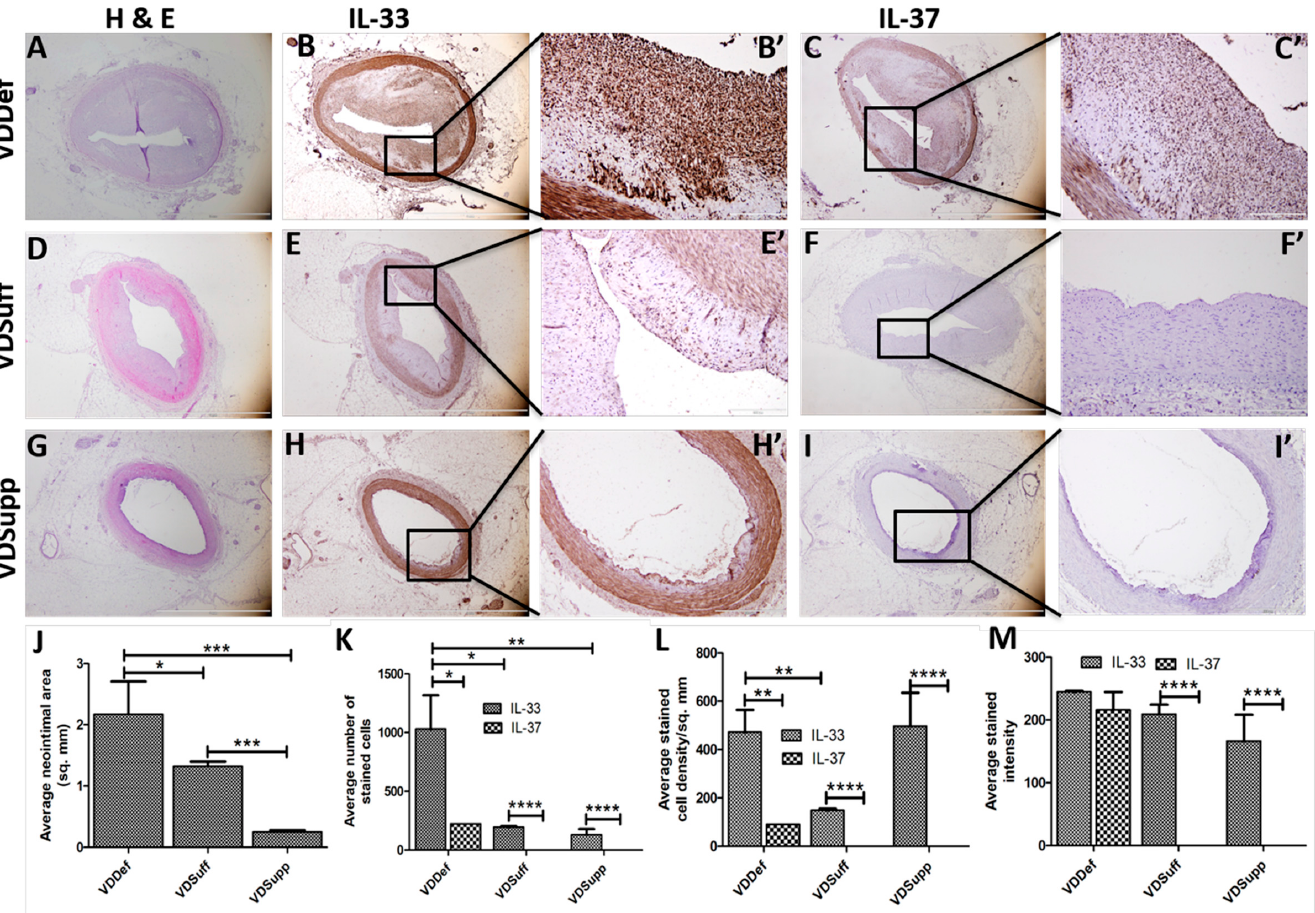
Figure 1. Hematoxylin and eosin and immunostaining for interleukin (IL)-33 and IL-37 in coronary arteries with angioplasty in vitamin D deficient, sufficient, and supplemented microswine. H & E staining in vitamin D deficient (panel ( A )), sufficient (panel ( D )), and supplemented microswine (panel ( G )). Immunohistochemistry for IL-33 (panels ( B , E , H )) and IL-37 (panels ( C , F , I )) in vitamin D deficient (VDDef), sufficient (VDSuff), and supplemented (VDSupp) groups, respectively. Panels ( B’ , C’ , E’ , F’ , H’ , I’ ) are the higher magnification images for the corresponding panels. Average neointimal area (panel ( J )), average number of IL-33- and IL-37-stained cells (panel ( K )), average stained cell density/mm 2 (panel ( L )), and average stained intensity (panel ( M )) in VDDef, VDSuff, and VDSupp microswine coronary arteries with angioplasty. All the images were scanned at 100 µ m. All data has been presented as mean ± SD (n = 3). A p -value of <0.05 was considered significant. * p < 0.05, ** p < 0.01, *** p < 0.01, and **** p <